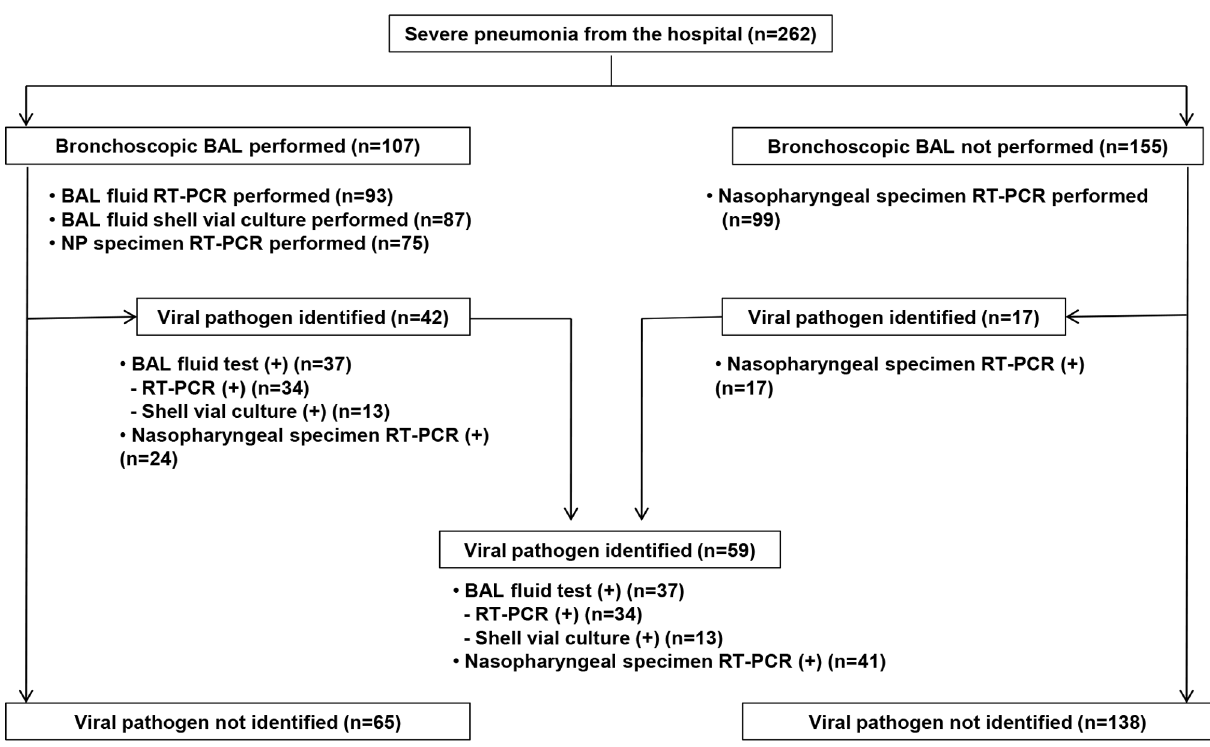
Figure 1. Flow diagram of the virus identification process in 262 patients with severe hospital-acquired pneumonia.